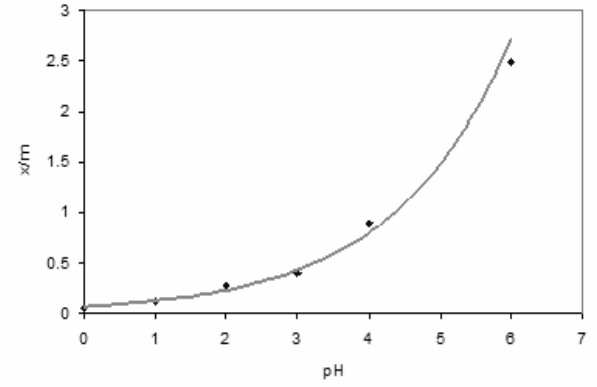
Figure 5 . The effect of pH on Hg 2+ sorption by PANi